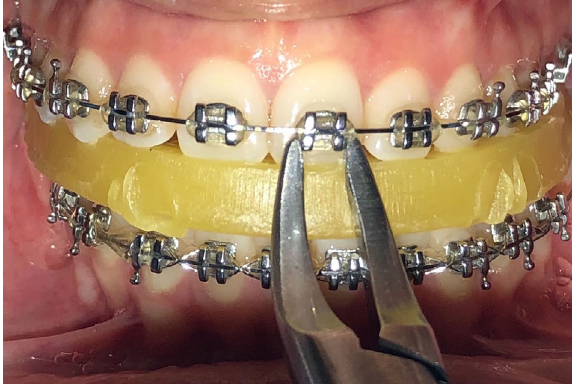
Figure 2- Intraoral photograph of debonding with soft bite wax